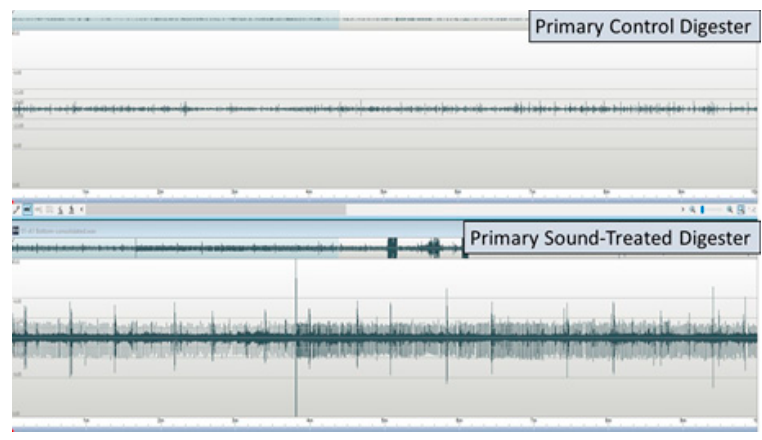
Figure 4. Background amplitude graphs of primary anaerobic digesters that had not been exposed to audio excitation (top) and which had been exposed to an ongoing treatment of two-h sound excitation, one-h silence.